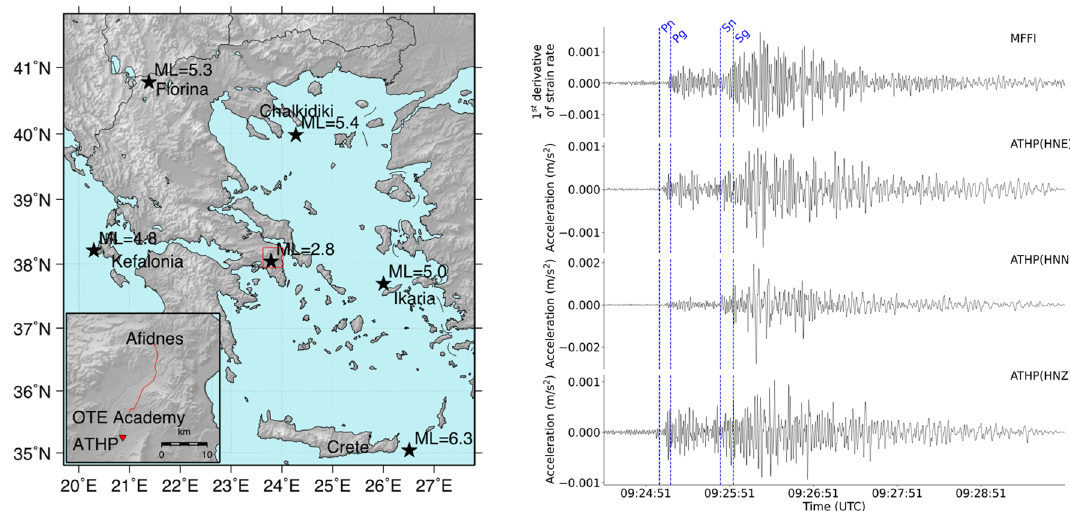
Figure 2. MFFI comparison to ATHP accelerometer. (Left) A map of Greece showing in a red box the location of MFFI system and ATHP accelerometric station (the inset magnifies the area contained in the rectangular frame) and the epicenters with black stars of earthquakes selected for analysis in the present study. (Right) Comparison of the time series collected by MFFI and ATHP regarding the earthquake taking place east of Crete Island (October 12, 2021, 09:24:03 UTC, Crete (ML = 6.3)). Pg/Sg, Pn/Sn theoretical arrival times are marked with blue dotted lines for reference. Map on the left has been created using open software GMT ver 5.4 (https:// www. gener ic- mappi ng- tools.